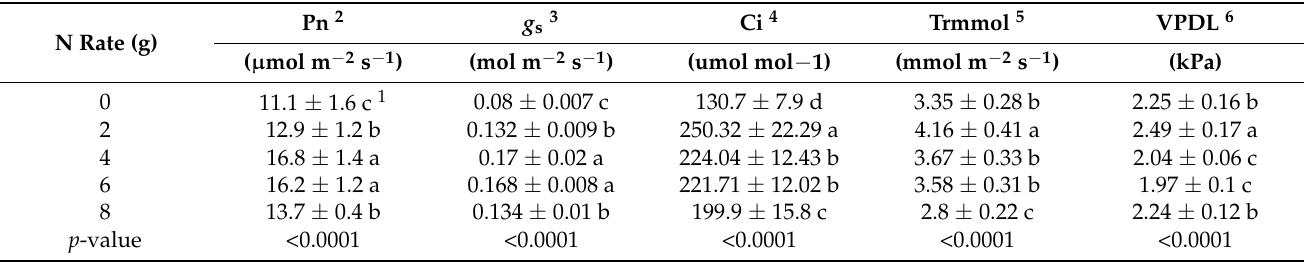
Table 4. Photosynthetic activities of plants receiving five N rates in